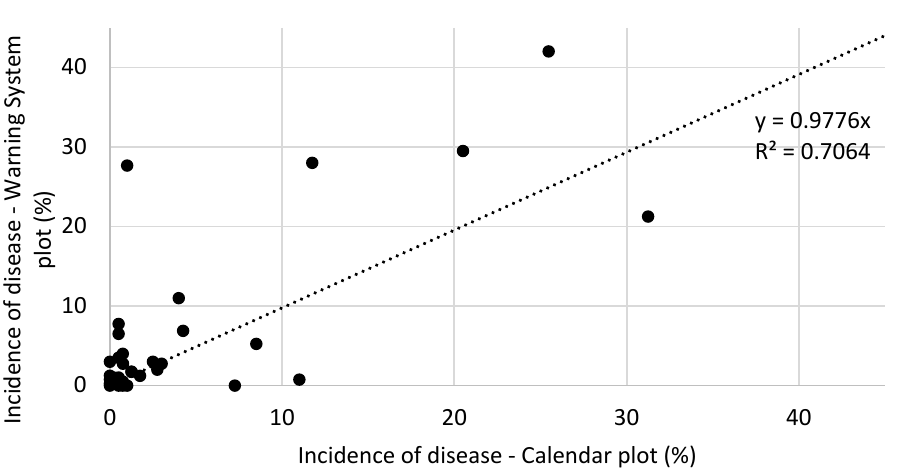
Figure 4. Correlation between the incidence of disease recorded in postharvest in the warning system and calendar plots plotted in Axis Y and X, respectively.